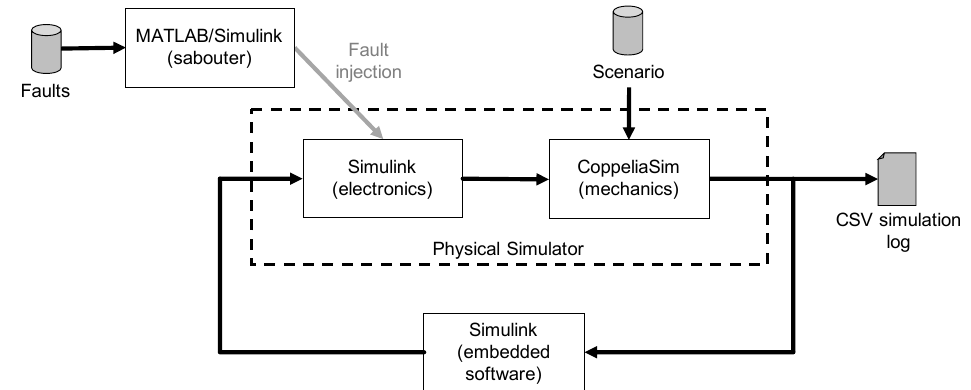
Figure 3. Scheme of the implemented simulation environment, with indication of the chosen